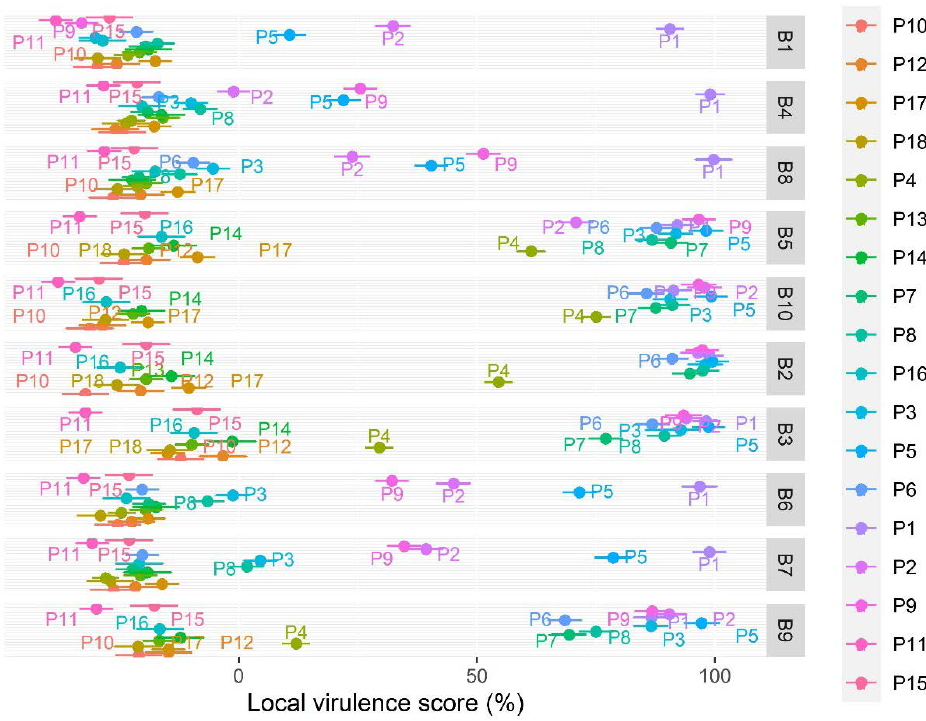
Figure 2. Virulence score average by bacteria and phage. A higher virulence score correlates with a higher virulence of the phage and higher bacterial growth reductions. The standard error is shown.